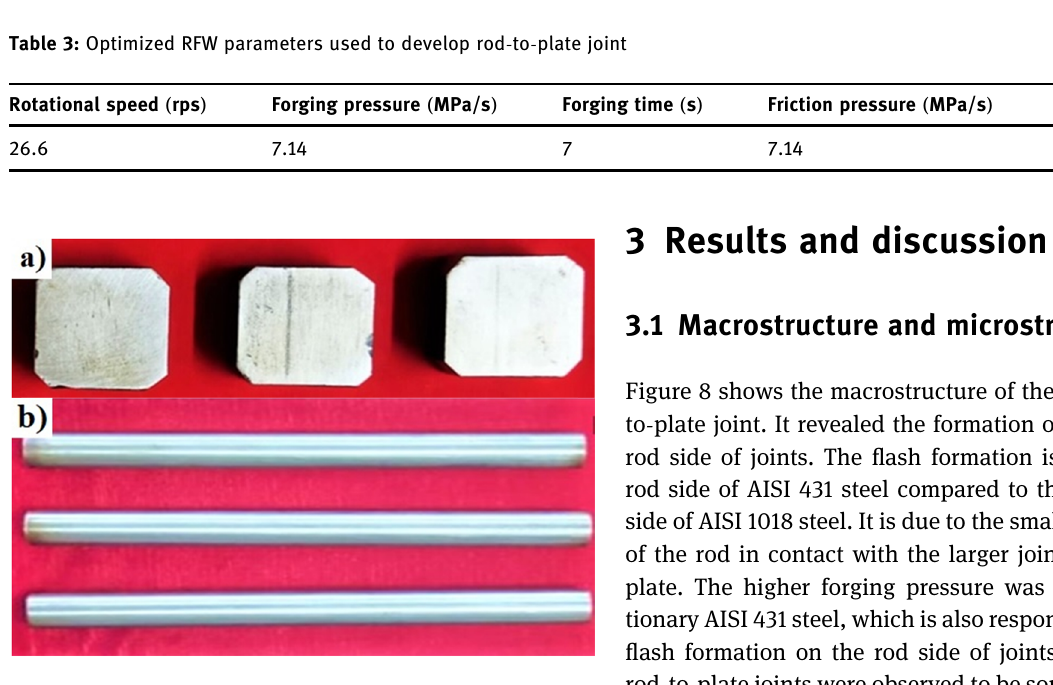
Figure 5: Photograph of unwelded ( a ) AISI 1018 steel plates and ( b ) AISI 431 steel rods.